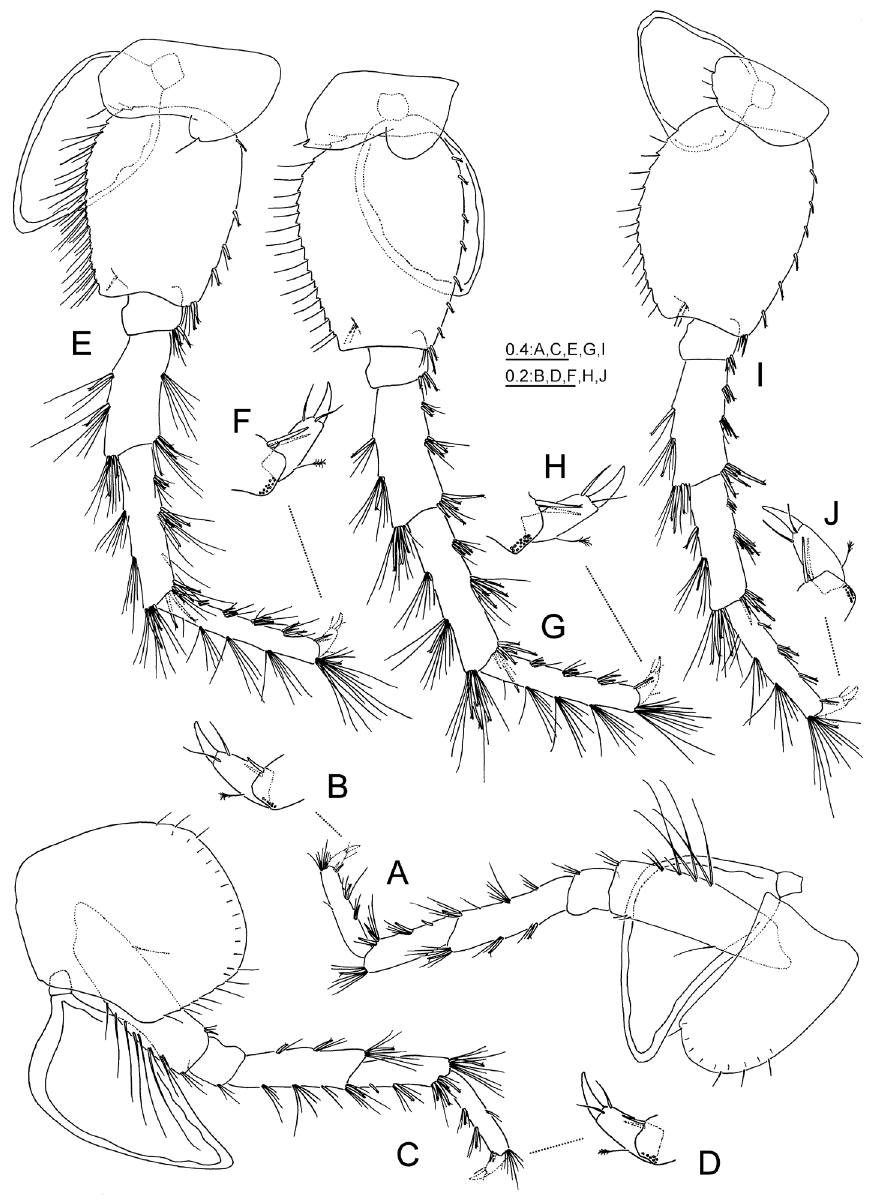
Figure 6. Zenkevitchia yakovi sp. n.: holotype, male (10.0 mm), X43382/Cr-1613-FEFU. A, C, E, G, I Pere- opods 3–7, lateral views B, D, F, H, J Enlarged dactyli of pereopods 3–7, lateral views. 1. Pereopods 3–7 (Figures 6A–J). Lengths of pereopods 3–4 equal. Dactylus 4 0.4× propodus 4; nail length 0.4× total dactylus length. Dactyli 3–4 with dorsal plumose seta; inner margin with 1 stiff seta and 1 thin seta at hinge. Lengths of pereopods 5 :